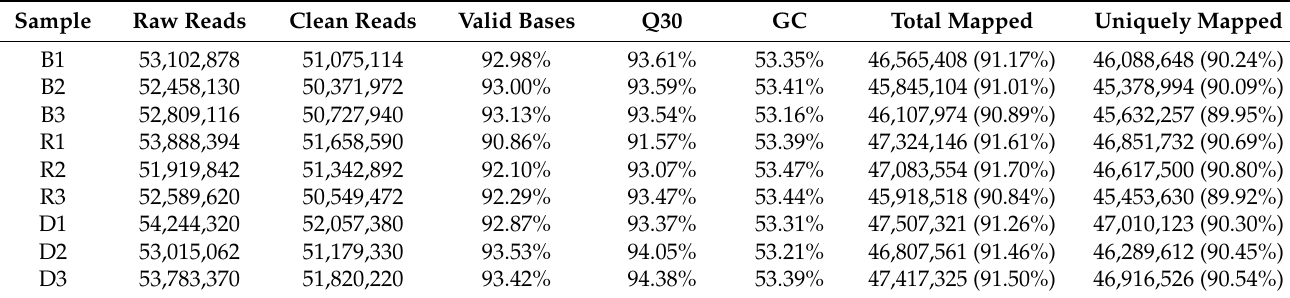
Table 1. Summary of the transcript expression levels.